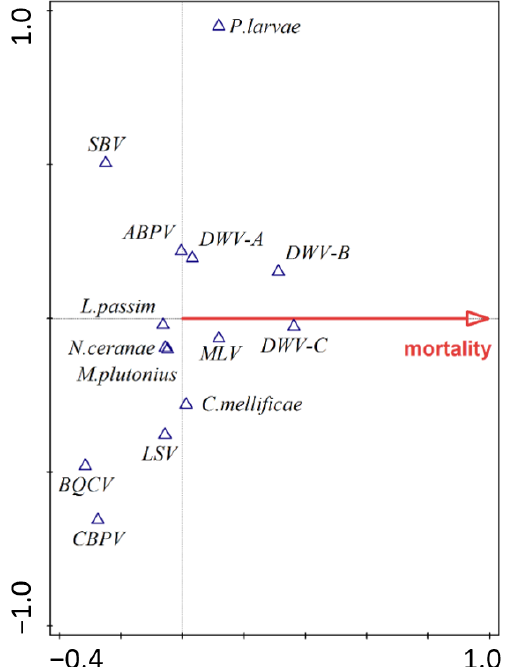
Figure 8. Partial canonical correspondence analysis biplot with the habitat type as a covariable showing the strength of the association of individual pathogens with the mortality rate.